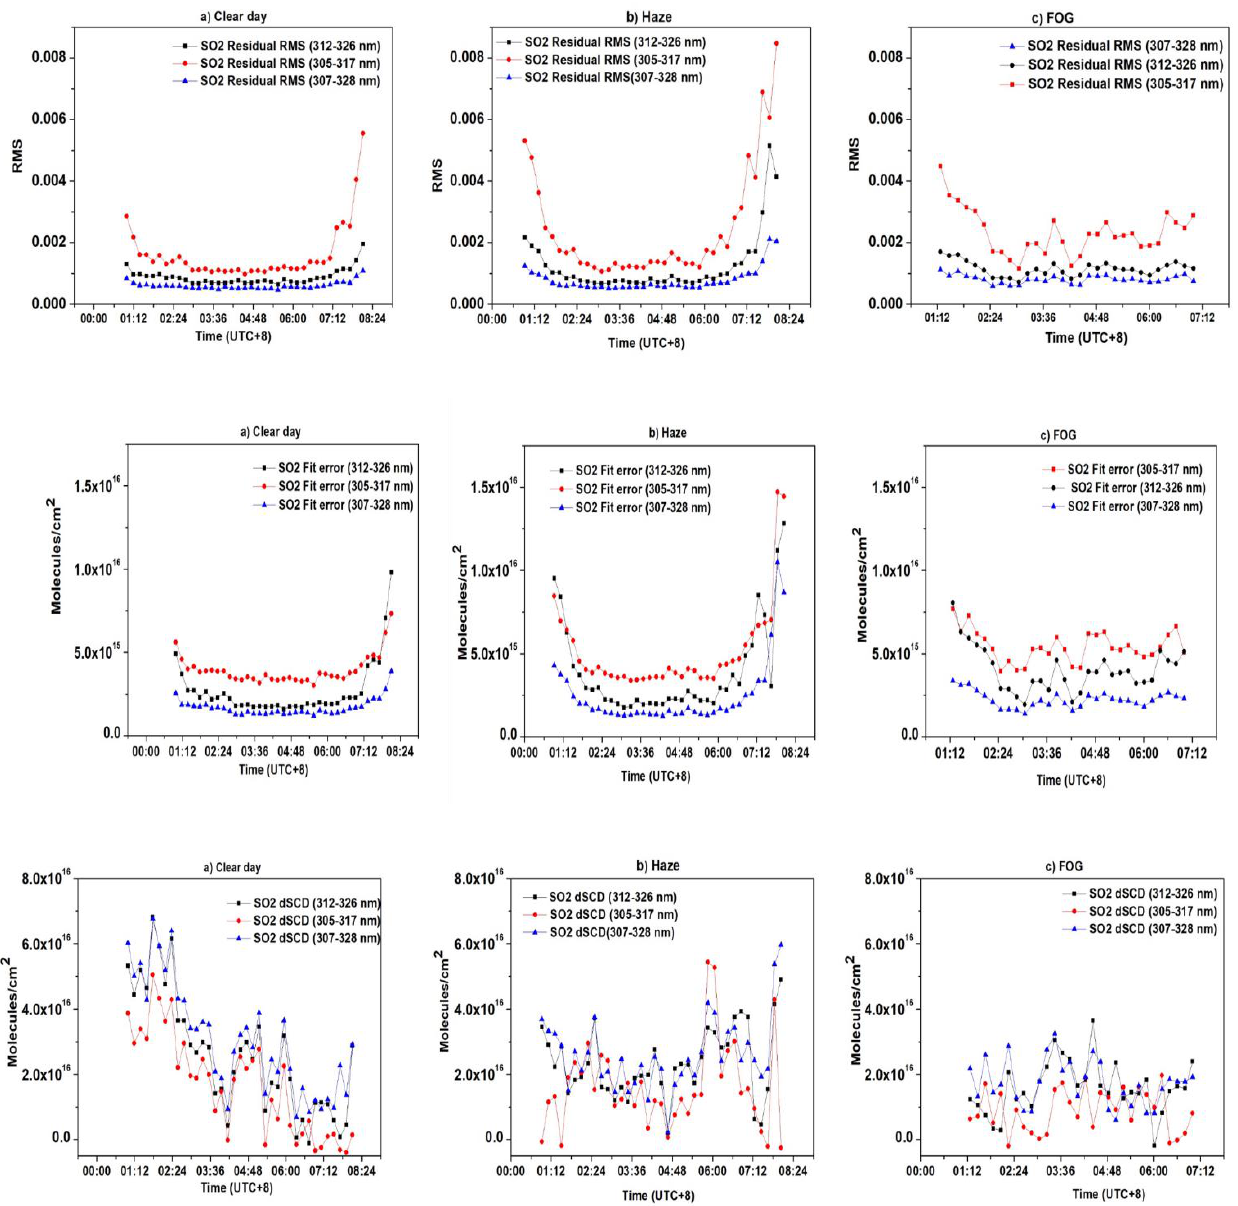
Figure 7. Intercomparison of different retrieval settings by parameters such as DOAS fit error, RMS, and SO 2 DSCDs on a ( a ) clear day (17 February 2020), ( b ) hazy day (31 January 2020), and ( c ) foggy day (13 February 2020).